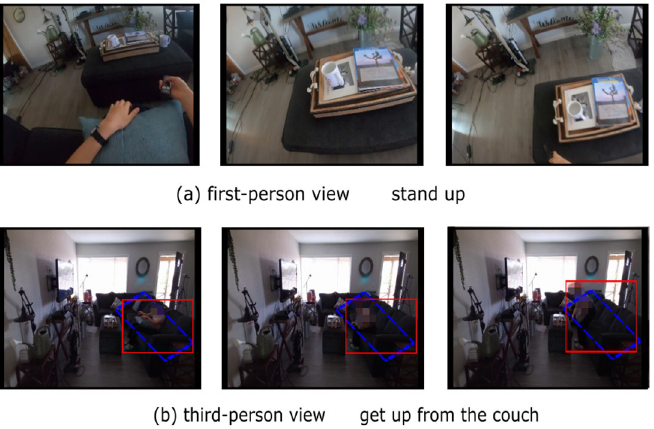
Fig 1. Examples of actions on LEMMA [3] dataset. (a) and (b) are images presented in different views at the same point in time. We have annotated the person by the red boxes and objects by the blue dashed boxes in (b). We can see the object moving away from the person and the person’s view is rising in (a), so we guess the action is standing up. But we can clearly see the person getting up from the couch in (b). We cannot recognize actions based on objects’ appearance in (a), but we can recognize actions in (b). Inspired by this, we aim at fusing information from different modalities for understanding compositional actions.